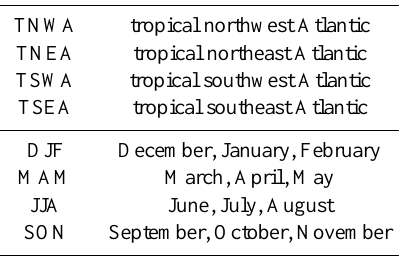
Table 1. Acronyms for the regions displayed in Fig. 1, and for the